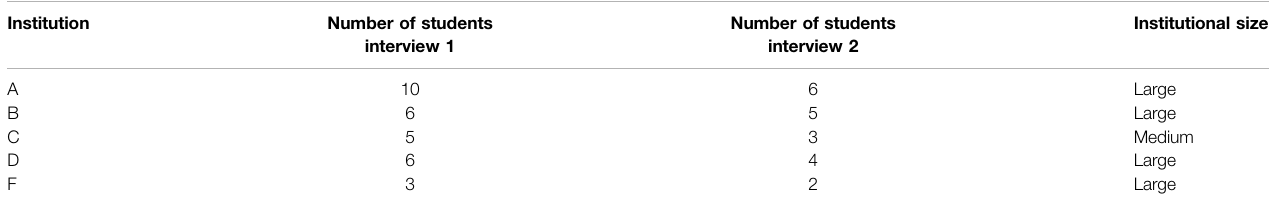
TABLE 3 | Students interviewed by institution and type.